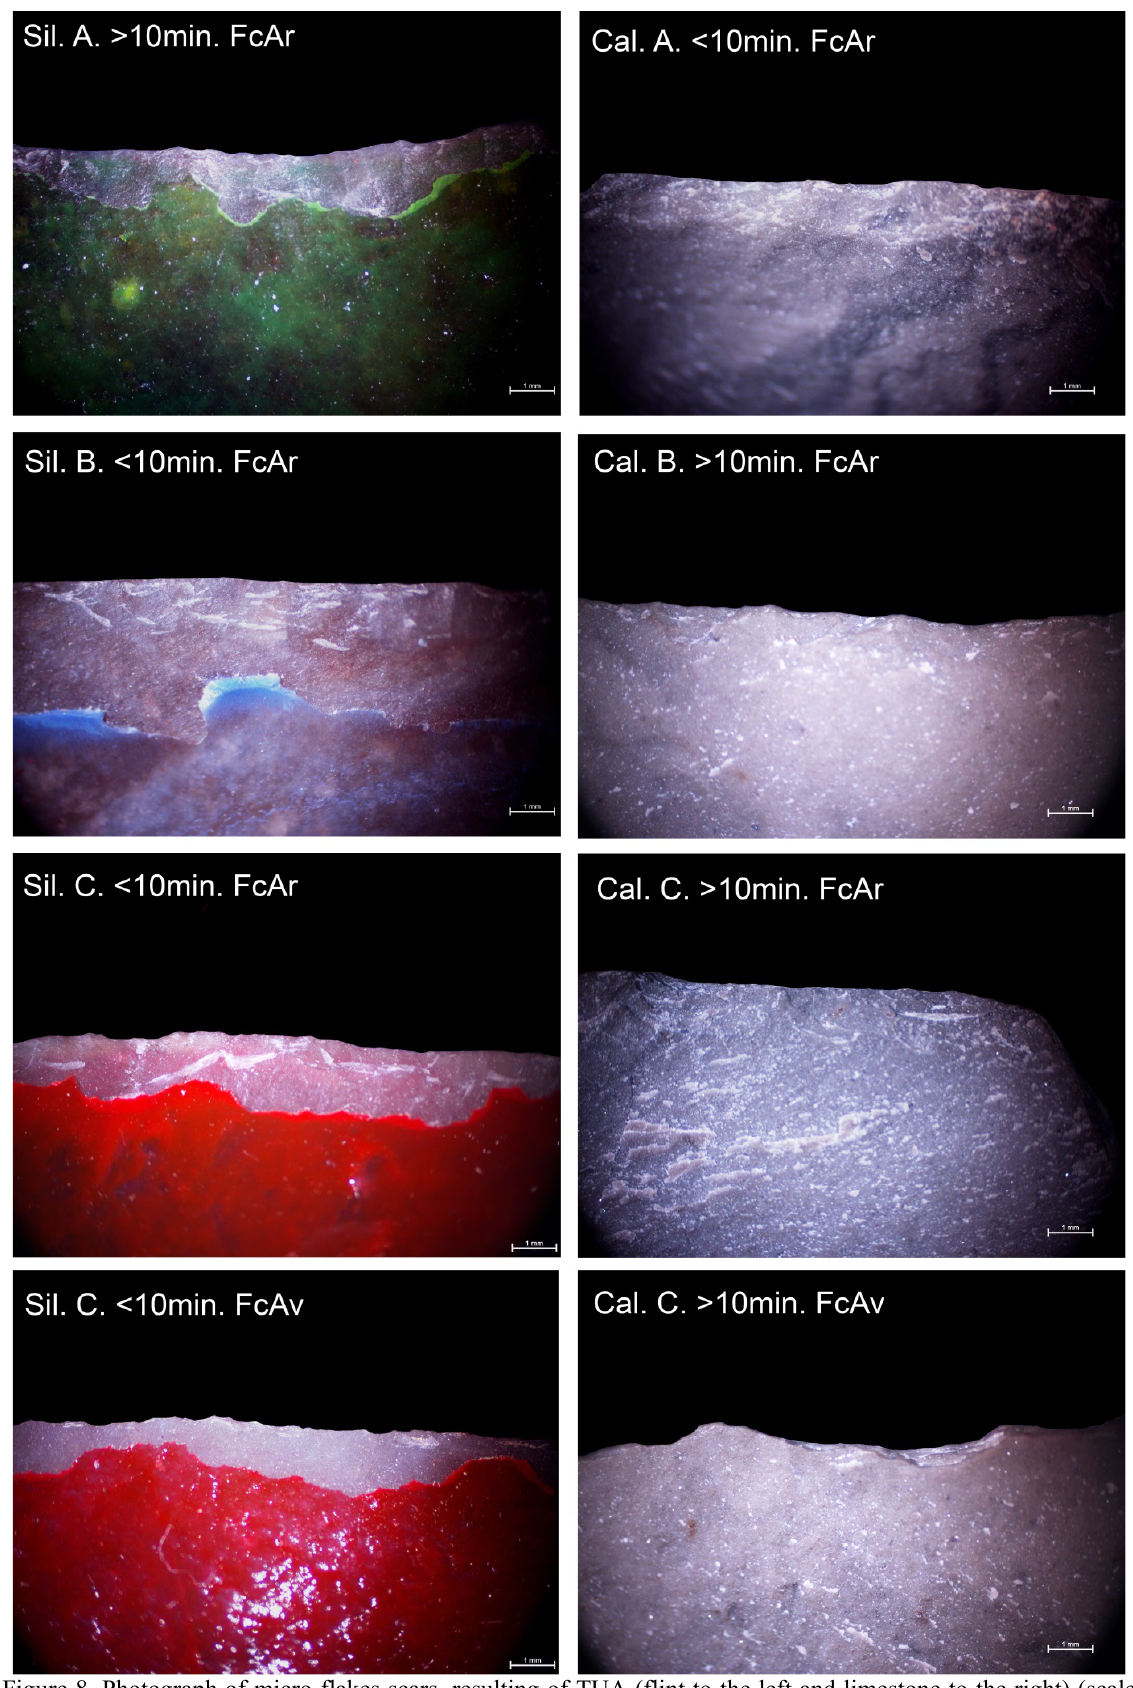
Figure 8. Photograph of micro-flakes scars, resulting of TUA (flint to the left and limestone to the right) (scale bar = 1